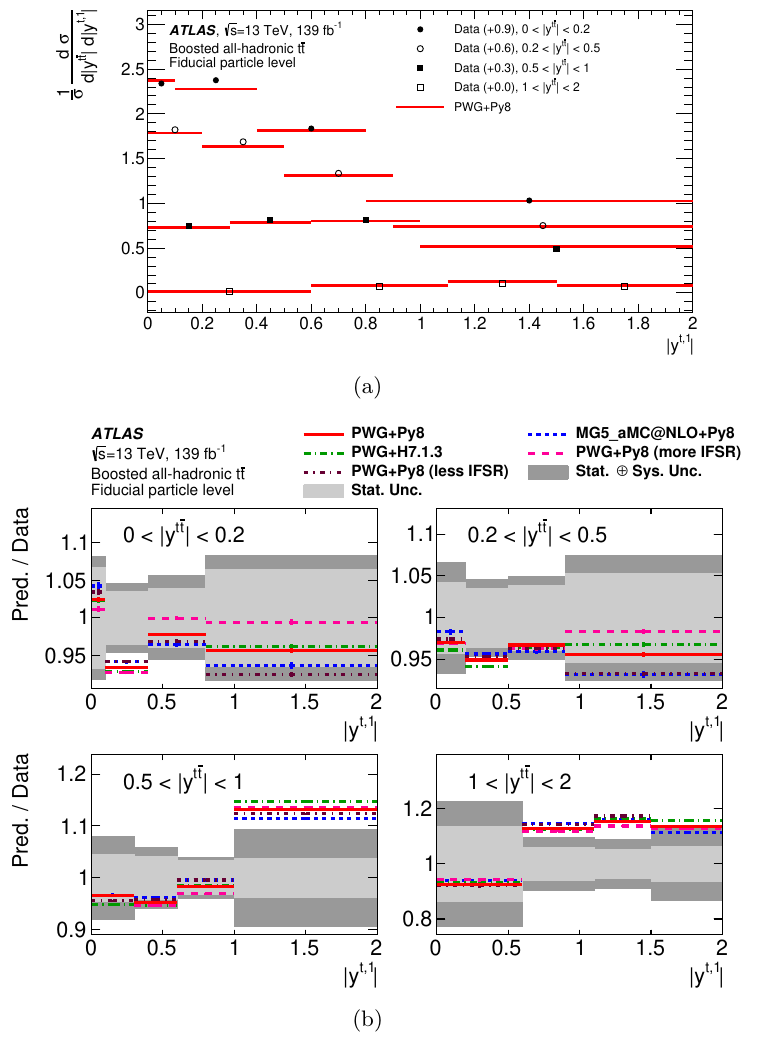
Figure 17 . (a) Normalized particle-level fiducial phase-space double-differential cross-sections as a function of the absolute value of the rapidity of the t ¯ t final state, the rapidity of the leading top-quark jet, compared with the Powheg+Pythia 8 calculation. Data points are placed at the centre of each bin and the Powheg+Pythia 8 calculation is indicated by solid lines. The measurement and the prediction are shifted by the factors shown in parentheses to aid visibility. (b) The ratios of various MC calculations to the normalized particle-level fiducial phase-space differential cross-sections. The dark and light grey bands indicate the total uncertainty and the statistical uncertainty, respectively, of the data in each